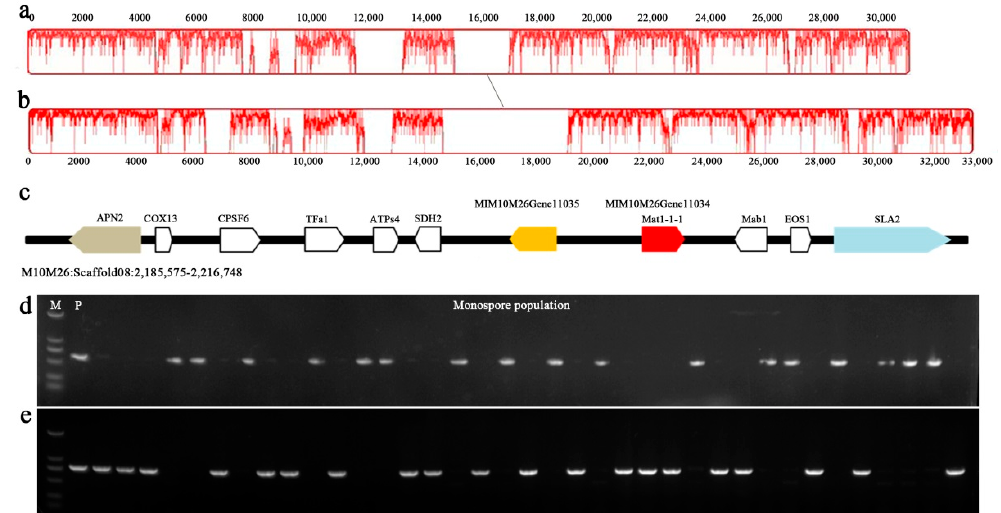
Figure 3. Collinearity analysis of Mat1-1 loci of M. crassipes and M. importuna. The diagonal line showed the Mat1-1 loci collinear region between M. crassipes ( a ) and M. importuna (GenBank accession number: MK527108) ( b ) by Mauve software, and the peak graph on the coordinate axis represented the degree of similarity of the collinear region. The gene order of the Mat1-1 locus of M. crassipes was shown ( c ). Electrophoresis maps represented the amplification of Mat1-1-1 ( d ) and Mat1-2 ( e ) genes in monosporic populations of M. crassipes (M, DM2000 molecular marker; P, M10 tissue isolation parent strain; 37 monosporic populations isolated from M10 ascocarp was used for mating structure detection).